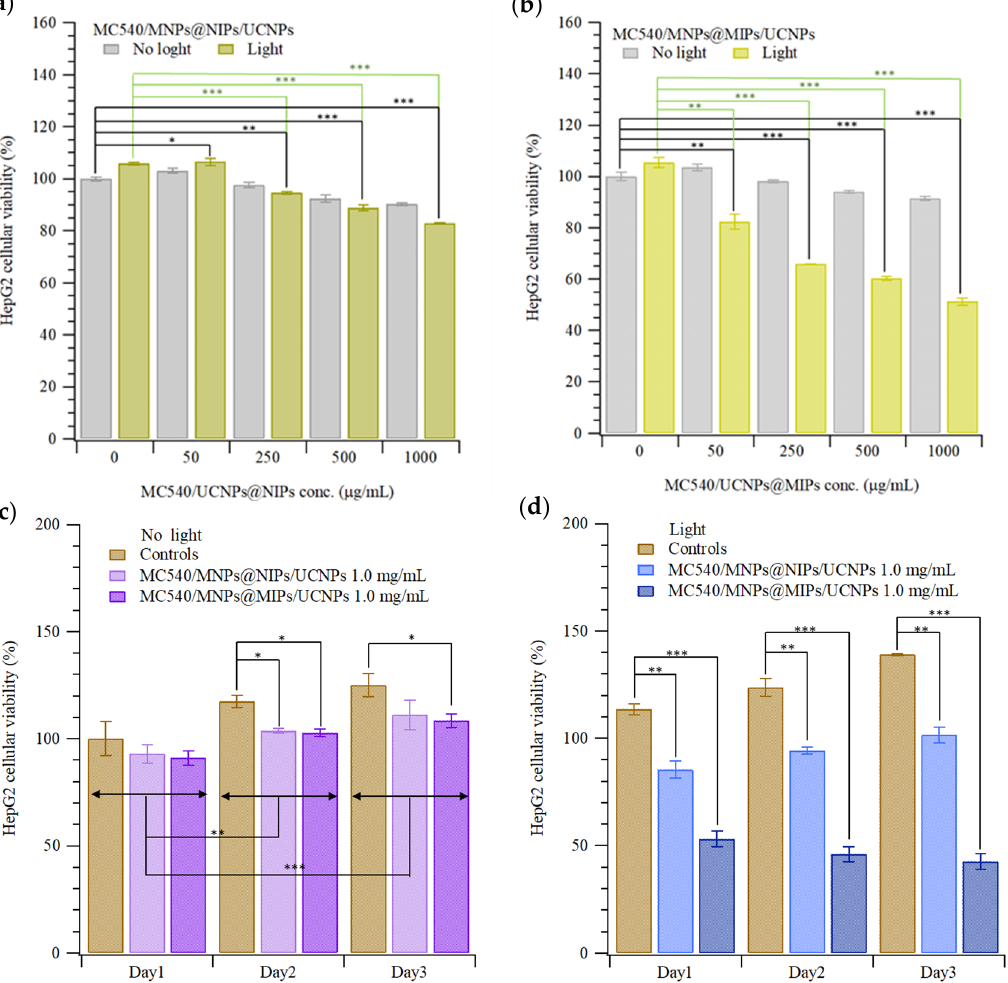
Figure 3. Cellular toxicity of HepG2 cells incubated with various concentrations of ( a ) NIPs and ( b ) MIPs with and without NIR irradiation (* p < 0.05, ** p < 0.001, *** p < 0.0001). Continuous cellular viability measurements of HepG2 cells incubated with 1.0 mg/mL of ( c ) NIPs and ( d ) PIPs/MC540 with and without irradiation (* p < 0.05, ** p < 0.001, *** p < 0.0001).